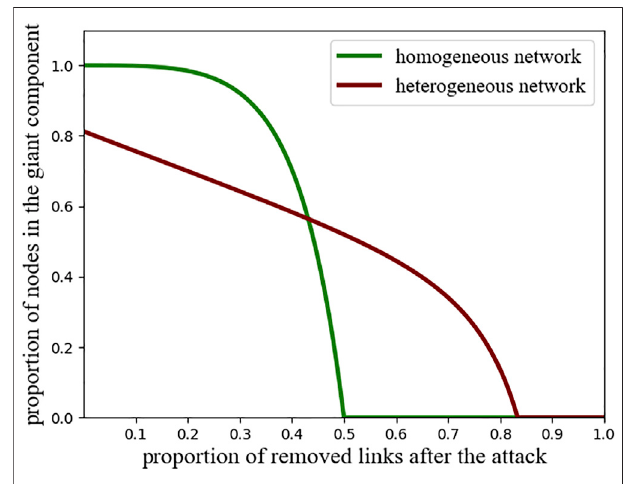
FIGURE5| Robustnessofhomogeneousandheterogeneousnetworks to random damage. Plotted isthe proportion ofnodes inthe giant component versusremovedlinksaftertheattackforahomogeneous(green, Eq.101 )and heterogeneous (red, Eq. 108 ). The homogeneous networks resist small attacks better whereas, the heterogeneous network survives a higher proportion of removal (Random node removal is described by the same curves, in this case, the proportion of the giant component refers to the proportion of remaining